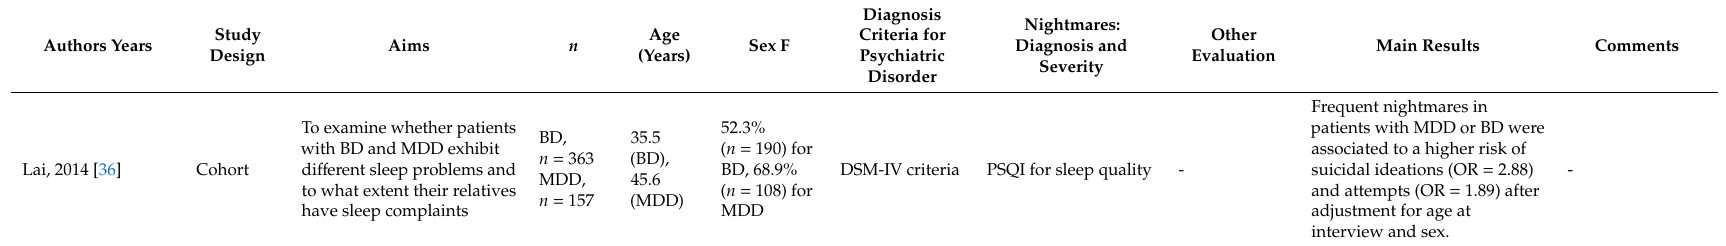
Table 1—Mood disorders and nightmares. F = Female; RDD = Recurrent Depressive Disorder; BD = Bipolar Disorder, MDD = Major Depressive Disorder; ME = Manic Episode; ND = No Data; PSQI = Pittsburgh Sleep Quality Index; DSM = Diagnostic and Statistical Manual of Mental Disorders; ICD-10 = International Statistical Classification of Diseases and Related Health